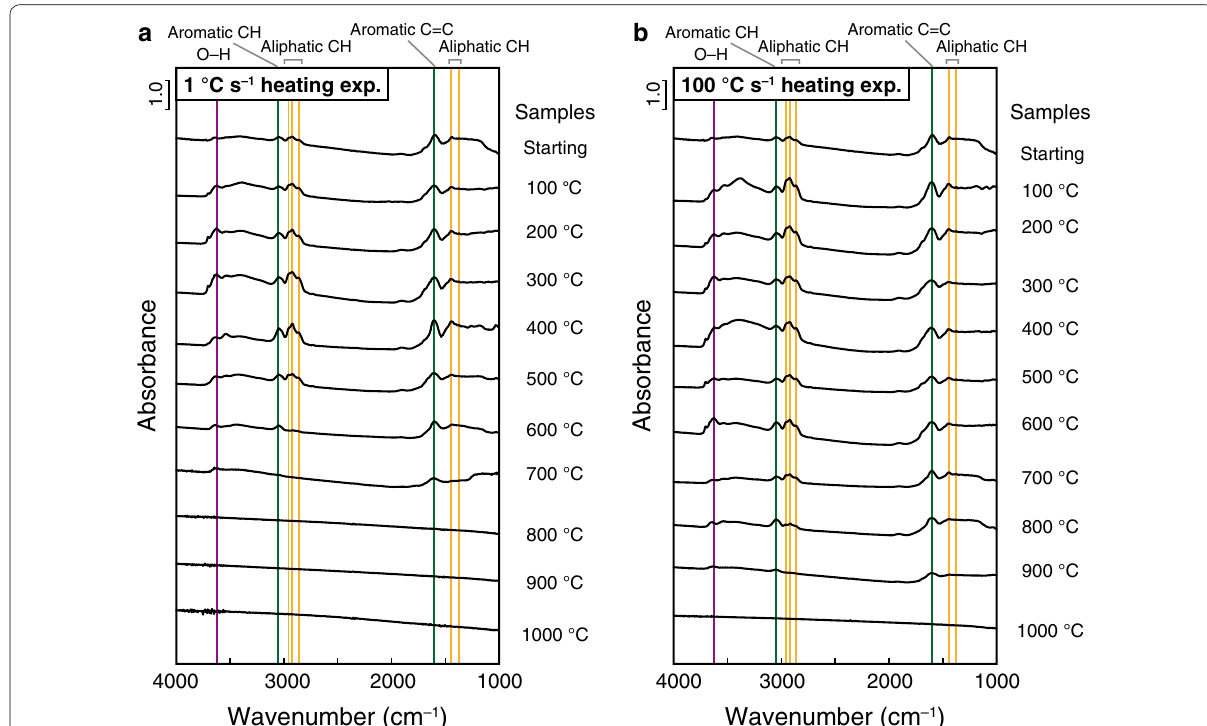
Fig. 2 Representative IR spectra of the analyzed CM. IR spectra of CM from shale and from products heated at a rate of a 1 °C s − 1 or b 100 °C s − 1 . exp .